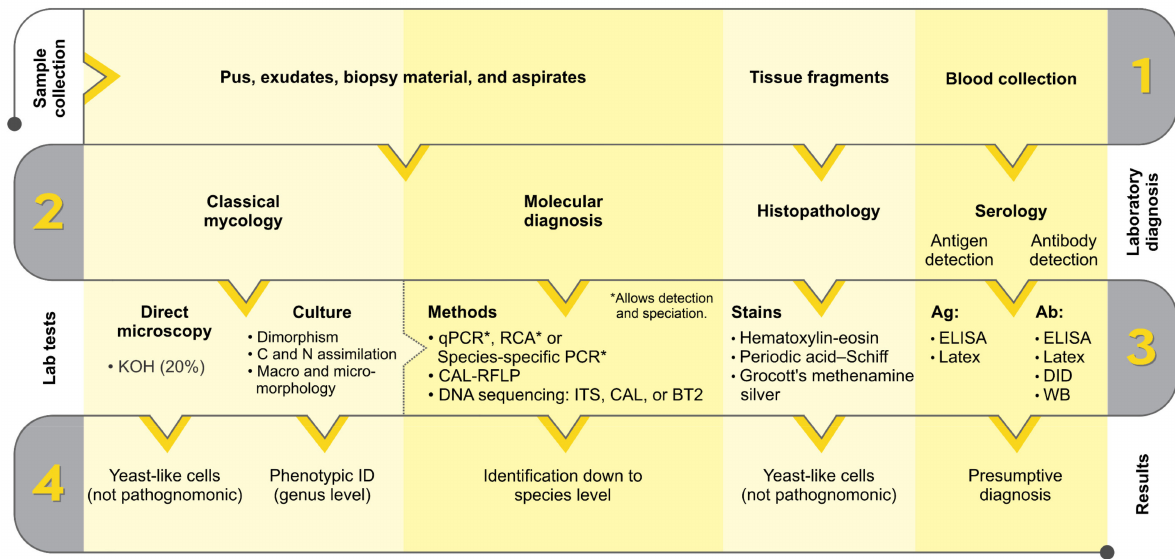
Figure 3. Flowchart for laboratory diagnosis of sporotrichosis. KOH: potassium hydroxide; C: carbon source; N: nitrogen source; qPCR: quantitative polymerase chain reaction; RCA: rolling circle amplification; PCR-RFLP: polymerase chain reaction-restriction fragment length polymorphism; ITS: internal transcribed spacer; CAL: calmodulin; BT2: β -tubulin; Ag: antigen detection; Ab: antibody detection; DID: double immunodiffusion; WB: Western